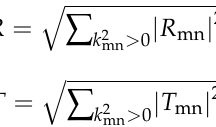
Figure 4. Comparison of the FEM and the analytical methods in ( a ) forward and ( b ) backward inci- dence.